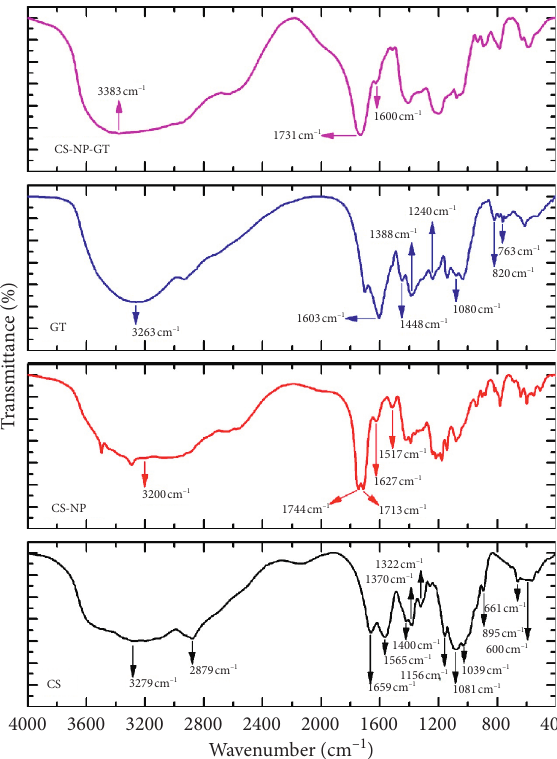
Figure 3: FT-IR spectra of CS-NP-GT (CS:GT � 1: 0.5), GT, CS- NP, and